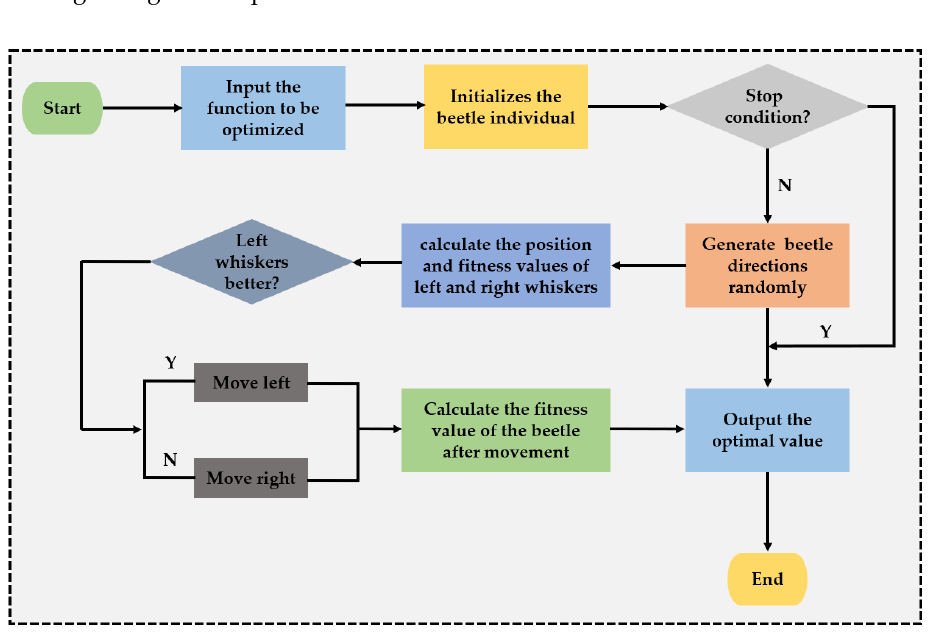
Figure 4. Introduction of BAS.